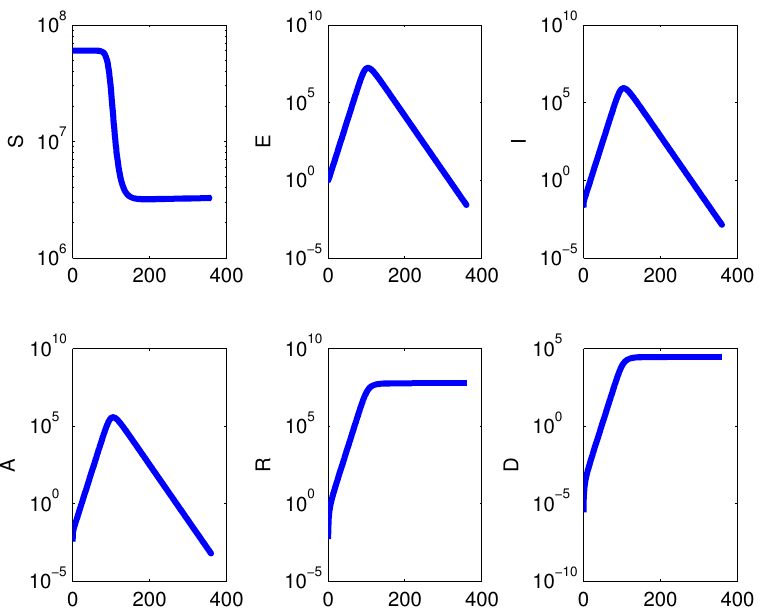
Figure 6. The epidemic’s effect on the population in the absence of measures for β I = 10 − 7 , on a semilogarithmic scale, over a period of one year. Left to right and top to bottom: S , E , I , A , R and D , the disease-related deceased